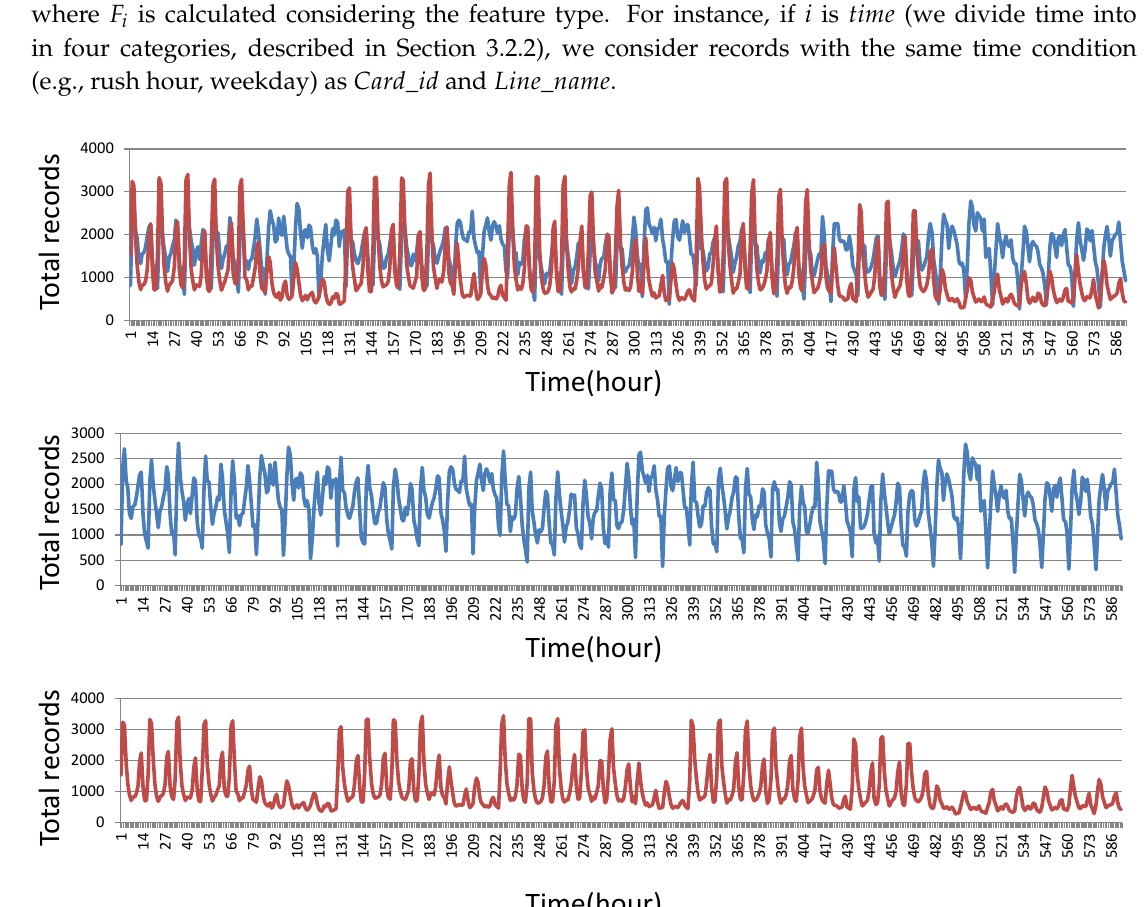
Figure 4. Frequent and occasional passengers of Bus Line